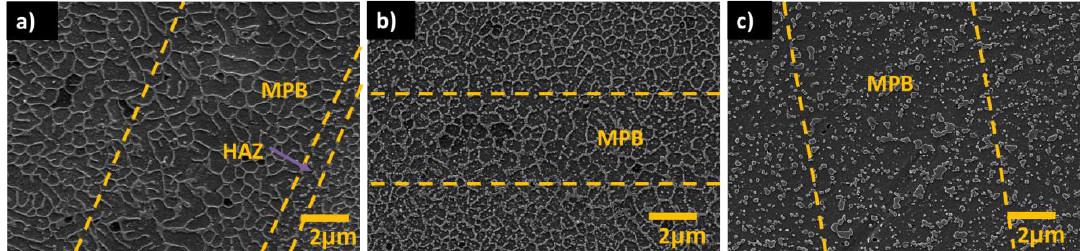
Figure 8. Secondary electron image showing the microstructure of ( a ) an as-built AM Al-Si sample (AlSi10Mg), as well as two stress-released specimens: one at 250 °C for 2 h ( b ), and another at 300 °C for 2 h ( c ). MPB refers to the melt pool border, while HAZ stands for the heat-affected zone. (Adapted from reference [54]).